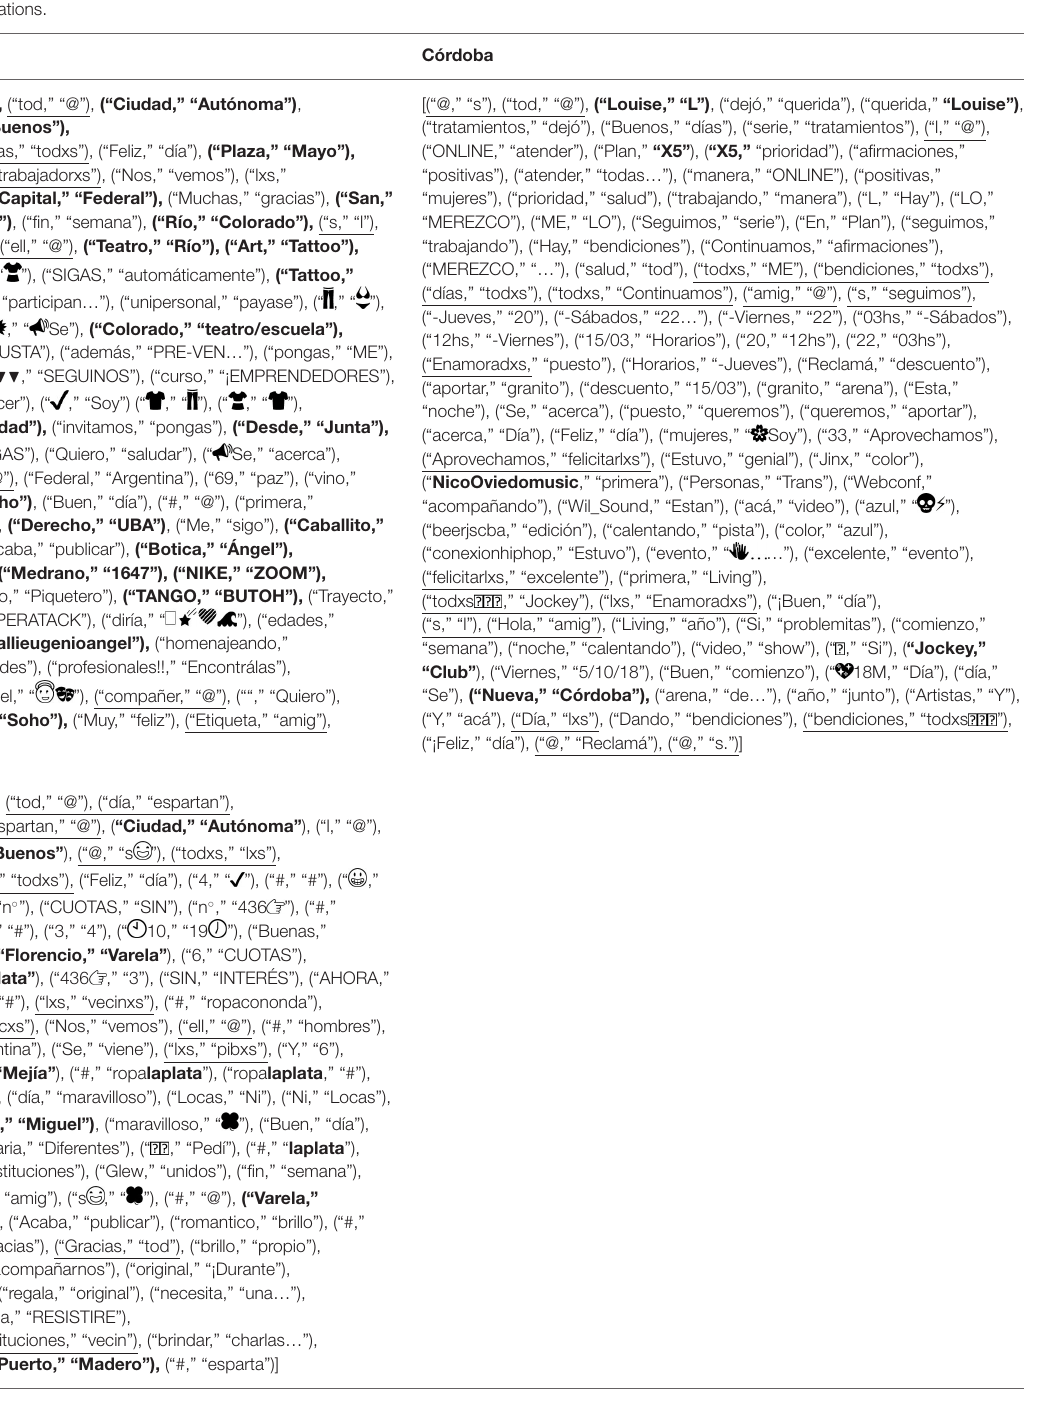
TABLE 2 | Most frequent